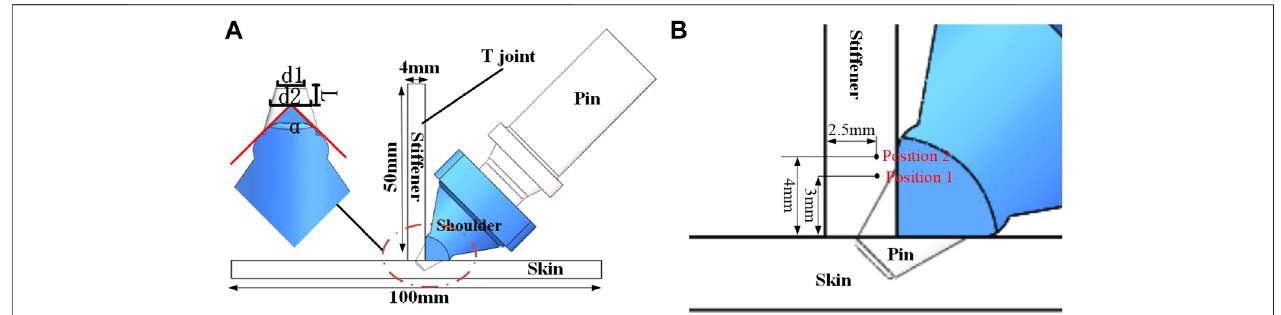
FIGURE 1 | CSSFSW mode (A) Dimensions of different components (B) Location for measuring the temperature.